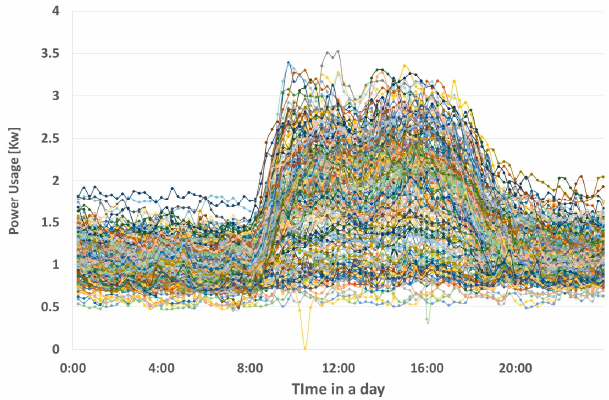
Figure 9. Load data from one building recorded in 2013, Korea.